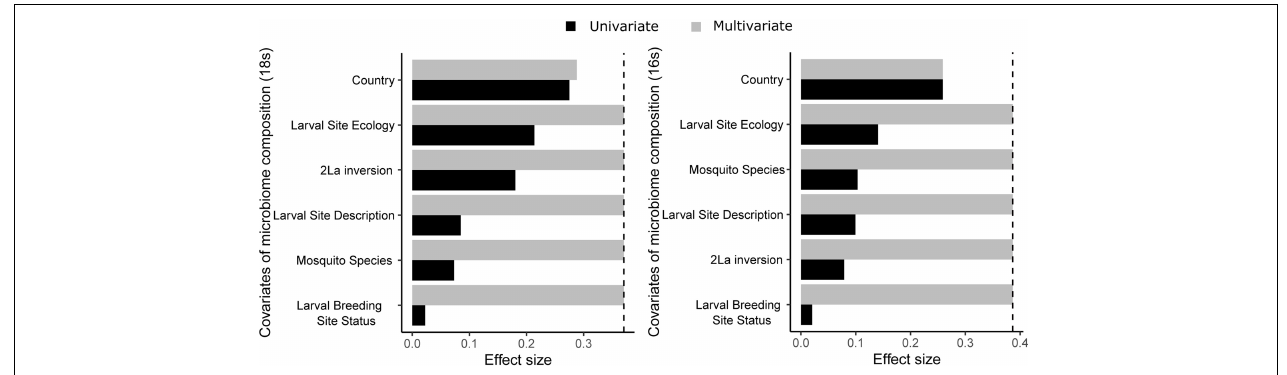
FIGURE 3 | Country of origin is the sample variable showing the greatest correlation with microbiome composition (dbRDA, genus-level Bray-Curtis dissimilarity) for both 18S rRNA gene data (left) and 16S rRNA gene data (right) from field collected samples. Data is shown for both an independent model (black bars; univariate effect sizes, CAP_r2ad) and a multivariate model (gray bars; cumulative effect sizes, RDAcumul_R2.ad). The cut-off for significant non-redundant contribution to the multivariate model is shown by the vertical dashed line. Larval site ecology is the ecology of the geographic region (i.e., deep forest, dry savannah etc.), larval site types are puddle, pond, mud brick pit etc. and larval pool status is whether the pool is temporary, semi-permanent or